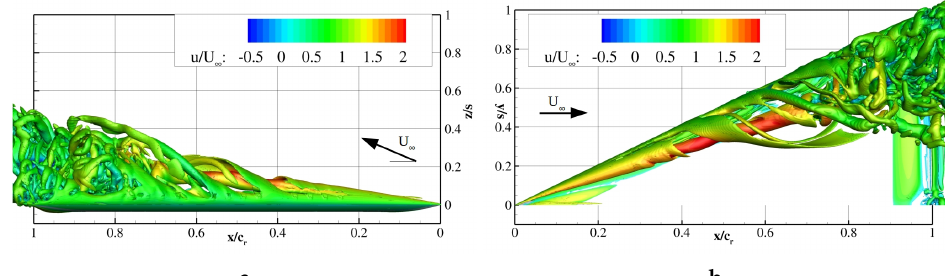
Figure 6. Computed Q-criterion Q = 10 5 s − 2 colored by the relative axial velocity; α = 23 ◦ , Re = 1.0 × 10 6 ; ( a ) side view and ( b ) top